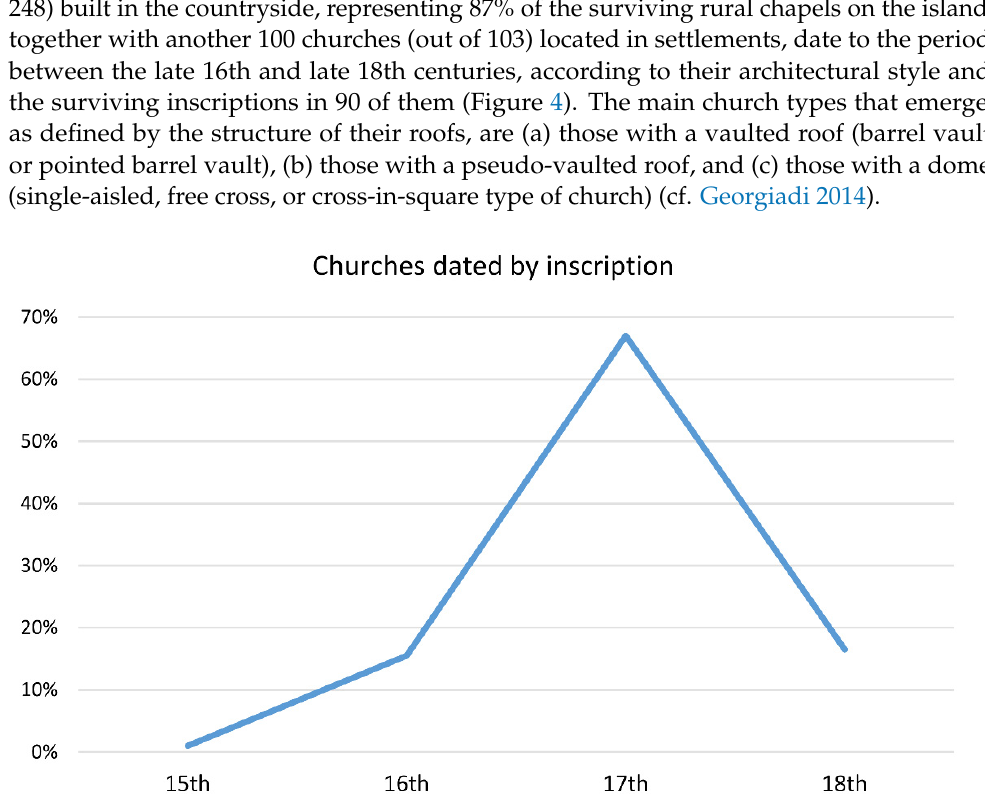
Figure 5. Representative examples of rural churches on Paros. ( a ). Pointed barrel-vaulted, free- standing church; ( b ). Barrel-vaulted (north chapel) and pointed barrel-vaulted (south chapel) twin churches; ( c ). Pointed barrel vault, interior; ( d ). Pseudo-vaulted free-standing church; ( e ). Pseudo- vaulted twin churches; ( f ). Pseudo vault with stone slabs, interior (photos by the author). 3.2. Churches with Pseudo-Vaulted Roof